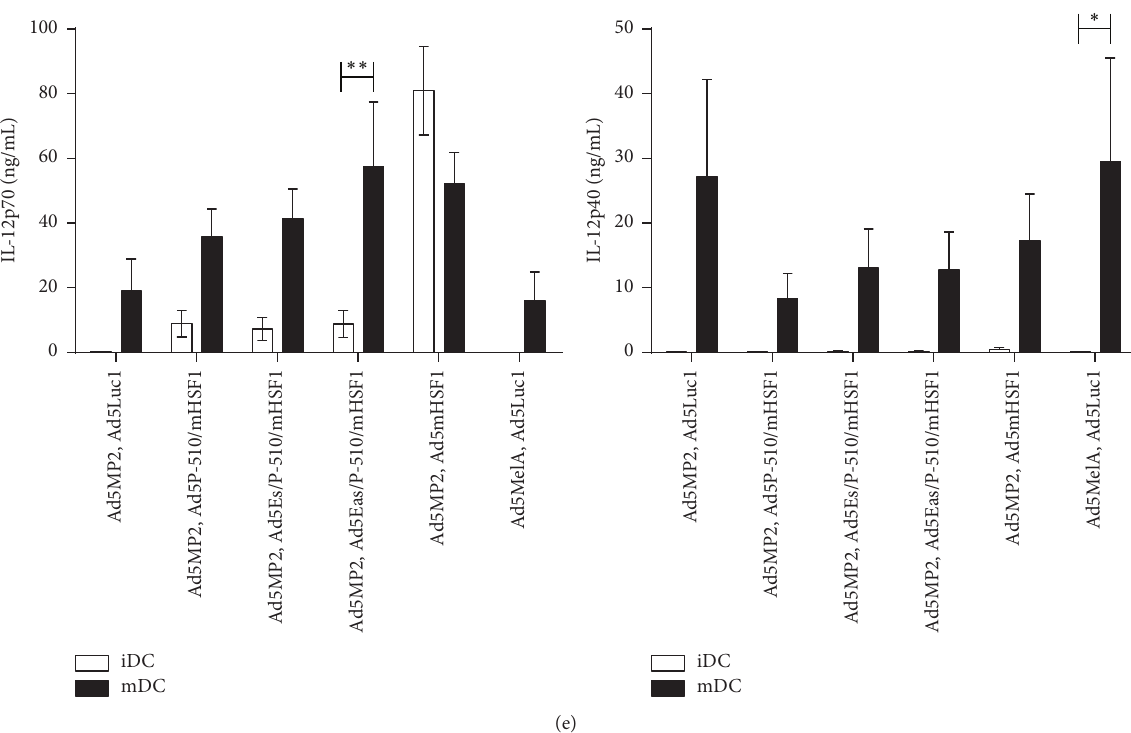
Figure 5: The “modular promoter (MP)” system enables highly efficient and specific expression of therapeutic transgenes in mature DCs. (a) Schematicoutlineofthedualvector“modularpromoter”system.Ad5E/P-510/mHSF1drivesexpressionofmHSF1underthecontrolofthecell type- and maturation-specific human CD83 promoter, which in turn induces specific induction of therapeutic transgenes MelanA and Il-12 by binding to the Hsp70B 󸀠 −29/−242 HRE encoded by Ad5MP2. (b, c) XS52 cells were cotransfected with a total amount of 2 𝜇 g of plasmid vectors pP-510/mHSF1, pEs/P-510/mHSF1, or pEas/P-510/mHSF1 in combination with plasmid vectors encoding the HRE alone (“pHsp70B 󸀠 −29/−242 ”) or the modular promoter system (“pMP2”). As a control, the empty pGL3-Basic vector (“Basic”) was used. (d, e) Human immature DCs were cotransduced with Ad5MP2 or Ad5MelA in combination with Ad5Luc1, Ad5mHSF1, Ad5P-510/mHSF1, Ad5Es/P-510/mHSF1, or Ad5Eas/P- 510/mHSF1. Cells were either left immature or were matured by adding 0.1ng/mL LPS. (b–e) Twenty hours after transfection, cell lysates were analyzed by Western Blot for expression of MelanA and beta-actin (b, d) and cell culture supernatants by ELISA for content of IL-12p40 and IL-12p70 (c, e). Either one representative (b, d) or data mean ± SEM from three independent experiments (c, e) is shown. ∗ 𝑃 < 0.05 ; ∗∗ 𝑃 < 0.01 ; bars without annotation are not significant ( 𝑃 > 0.05 ), one-way ANOVA (c) or two-way ANOVA (e) with Bonferroni’s Multiple Comparison post hoc